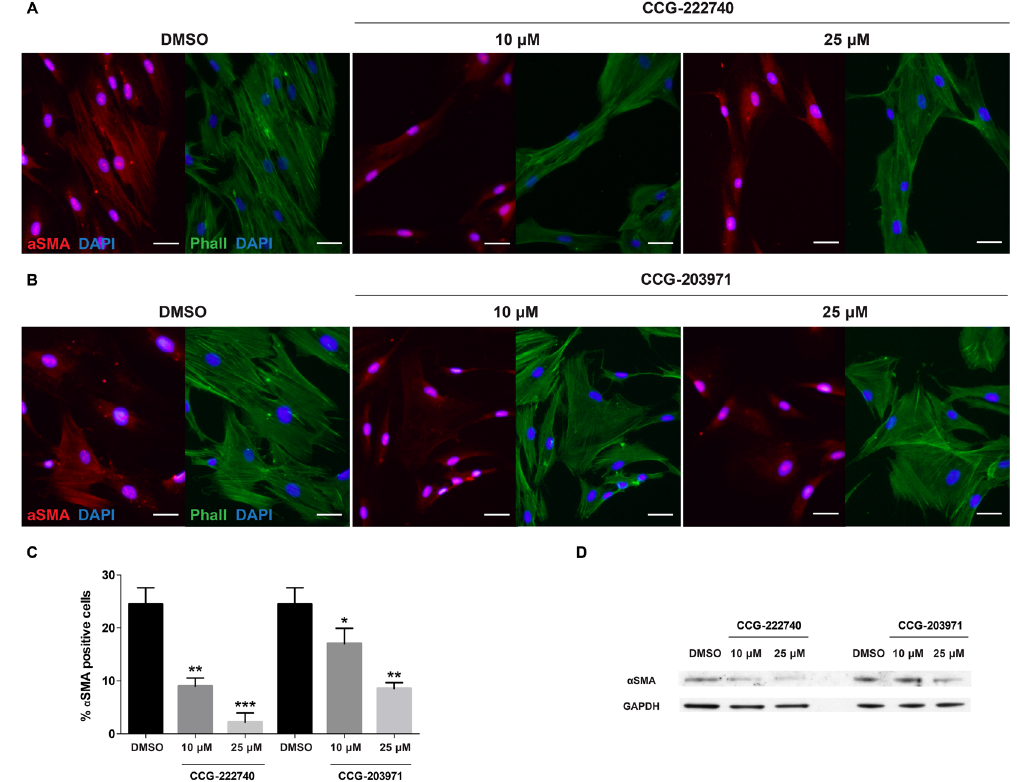
Figure 3. CCG-222740 is more potent than CCG-203971 at decreasing α SMA protein expression. ( A , B ) Human conjunctival fibroblasts were treated for 48 hours with 10 or 25 μ M of CCG-222740 or CCG-203971 or 0.1% DMSO control in DMEM + 10% FCS. The fibroblasts were stained with Cy3-labelled alpha smooth muscle actin antibody, phalloidin and DAPI. Scale bar = 30 μ m; ( C ) Fibroblasts that are positive for α SMA clearly display α SMA-positive stress fibres, which were quantified visually from three random fields of view per treatment group. Results represent mean ± SEM for triplicate experiments. * P < 0.05; ** P < 0.01; *** P < 0.001. ( D ) Western blot analysis of α SMA protein expression in human conjunctival fibroblasts treated with CCG- 222740 or CCG-203971 as in ( A , B ). Cropped blots are displayed and the full-length blots are shown in Supplementary Figure